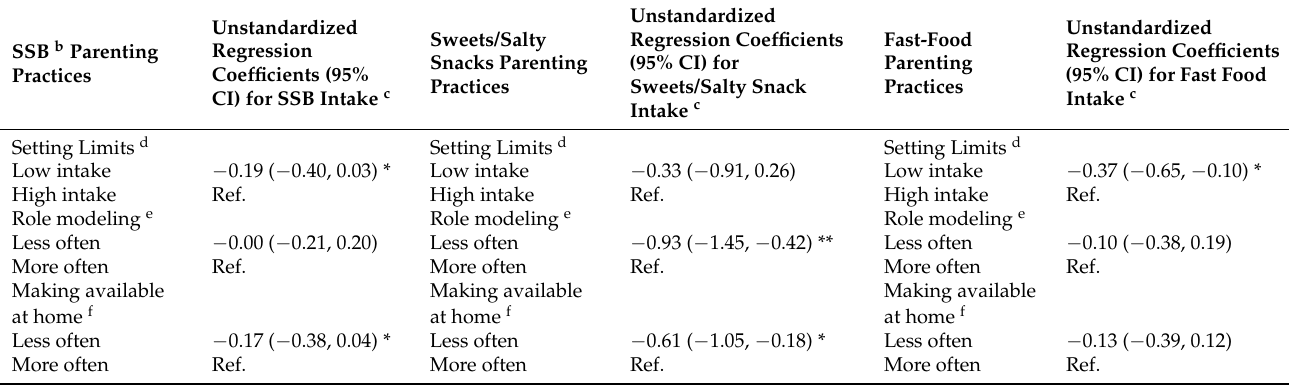
Table 3. Adjusted associations between adolescent-reported sweets/salty snack, SSB, and fast food intakes and fathers’ food parenting practices ( n = 191) a